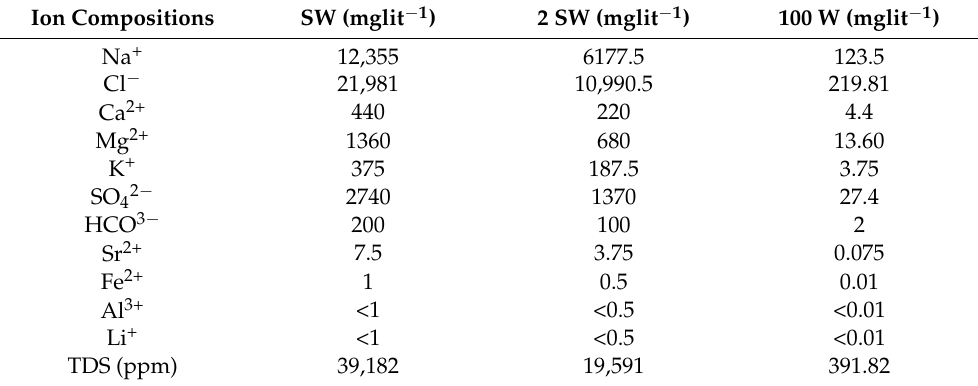
Table 2. Salt compositions and TDS of three types of brine solutions used for dynamic oil displace- ment, IFT, and contact angle